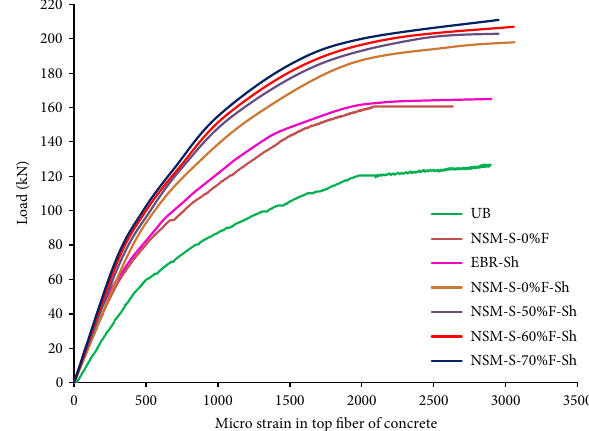
Figure 7. Load versus concrete compressive strain of beam specimens